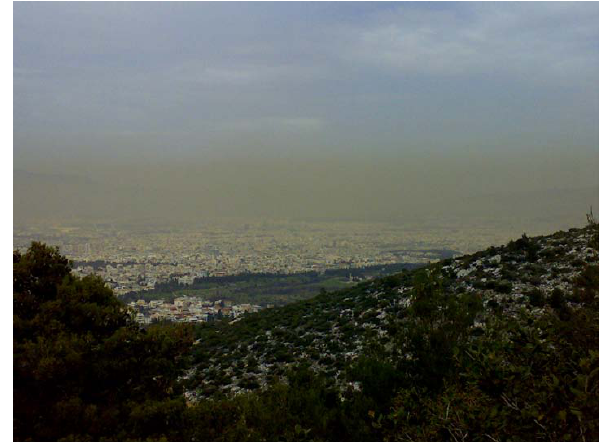
Figure A1. Mixture of Saharan dust aerosols and local air pollution over Athens, Greece. Fig. A1. Mixture of Saharan dust aerosols and local air pollution Photo taken on 31 March 2009. over Athens, Greece. Photo taken on 31 March